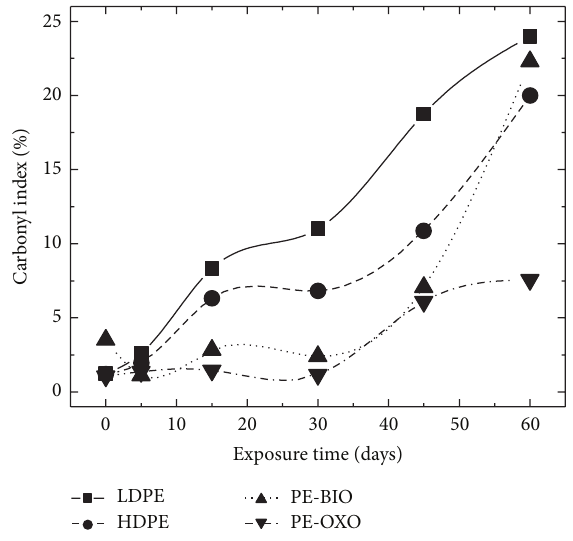
Figure2:Carbonylindex( 𝐼 CO )oftheLDPE( ◼ ),HDPE( 󳵳 ),PE-BIO ( 󳶃 ), and PE-OXO ( e ) films exposed to UV-B